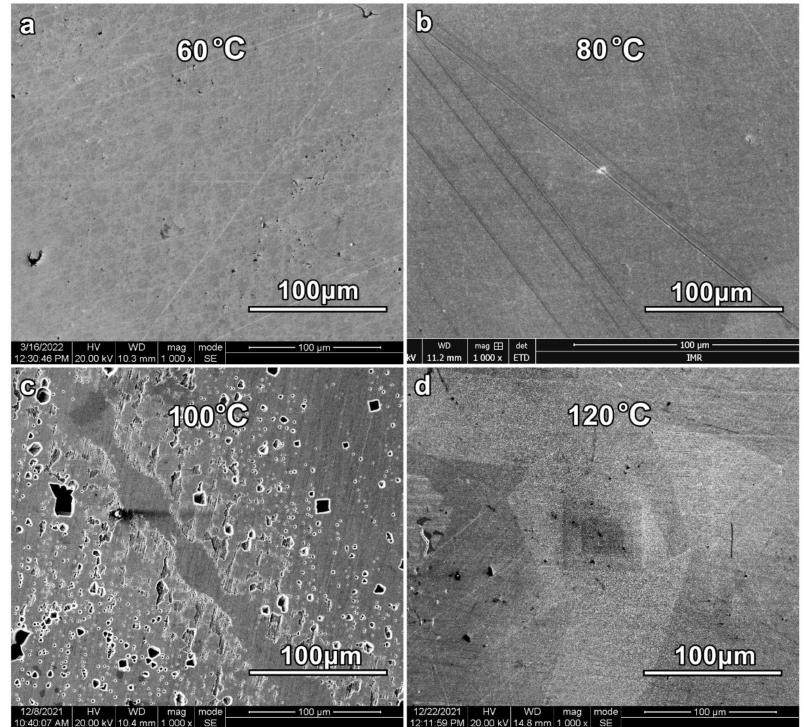
Figure 15. Morphology of 304L stainless steel corroded in condensate phase at different